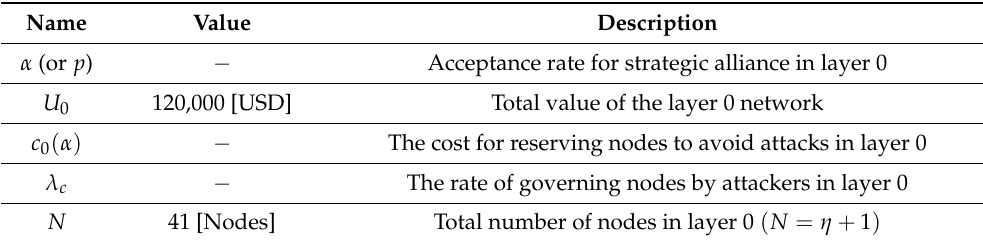
Table 2. Initial conditions for layer